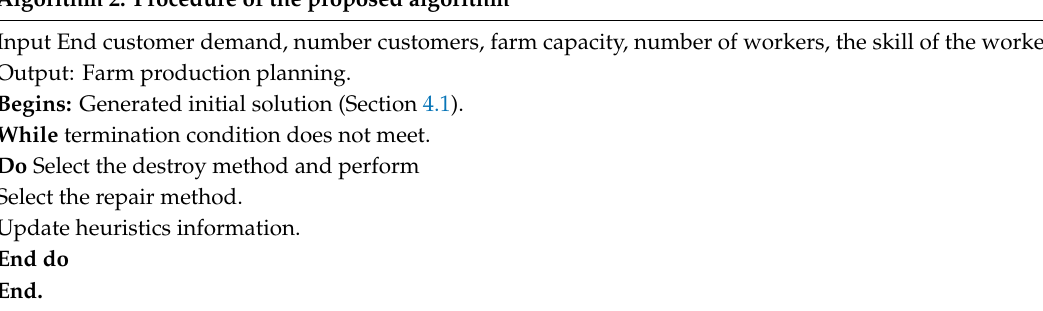
Algorithm 2. Procedure of the proposed